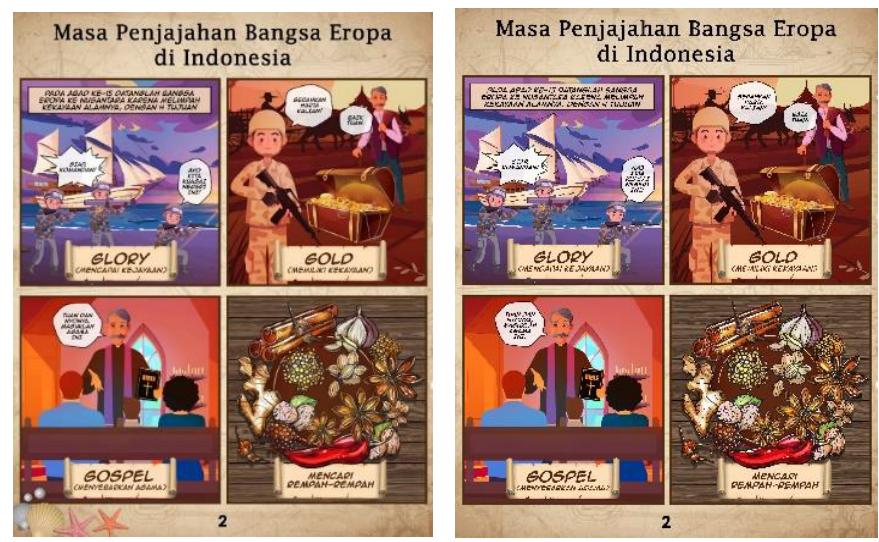
Figure 5. The display of e-comic after